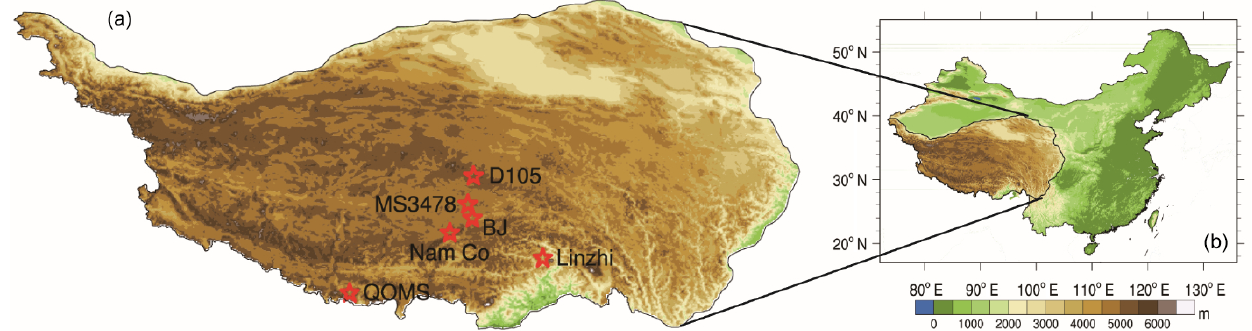
Figure 1. Location of the Tibetan Plateau. Panel (b) illustrates the location of the Tibetan Plateau in China. Panel (a) shows the spatial distribution of eddy-covariance stations in the Tibetan Plateau. The pentagrams represent the eddy-covariance stations in the Tibetan Plateau. The legend of the color map indicates the elevation above mean sea level in